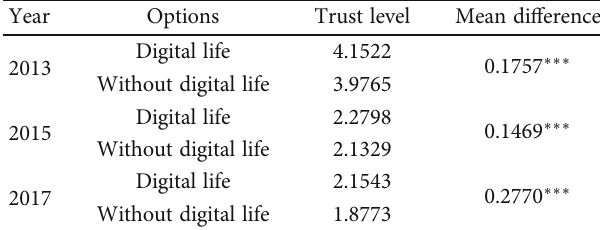
Table 3: Univariate